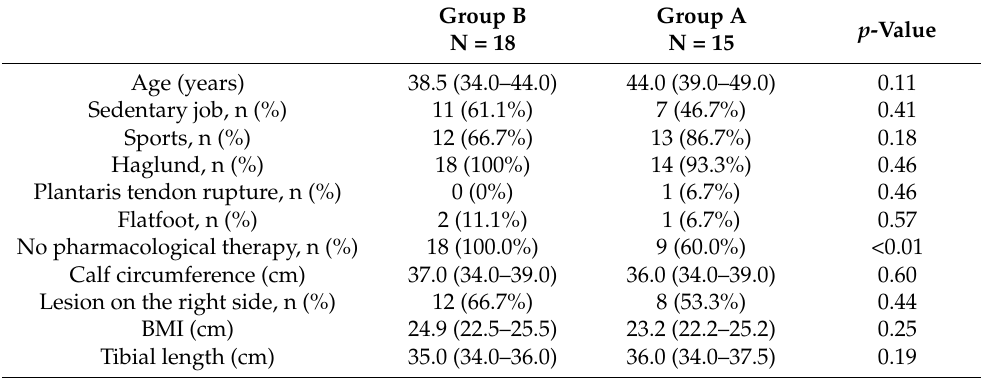
Table 4. Patients features.